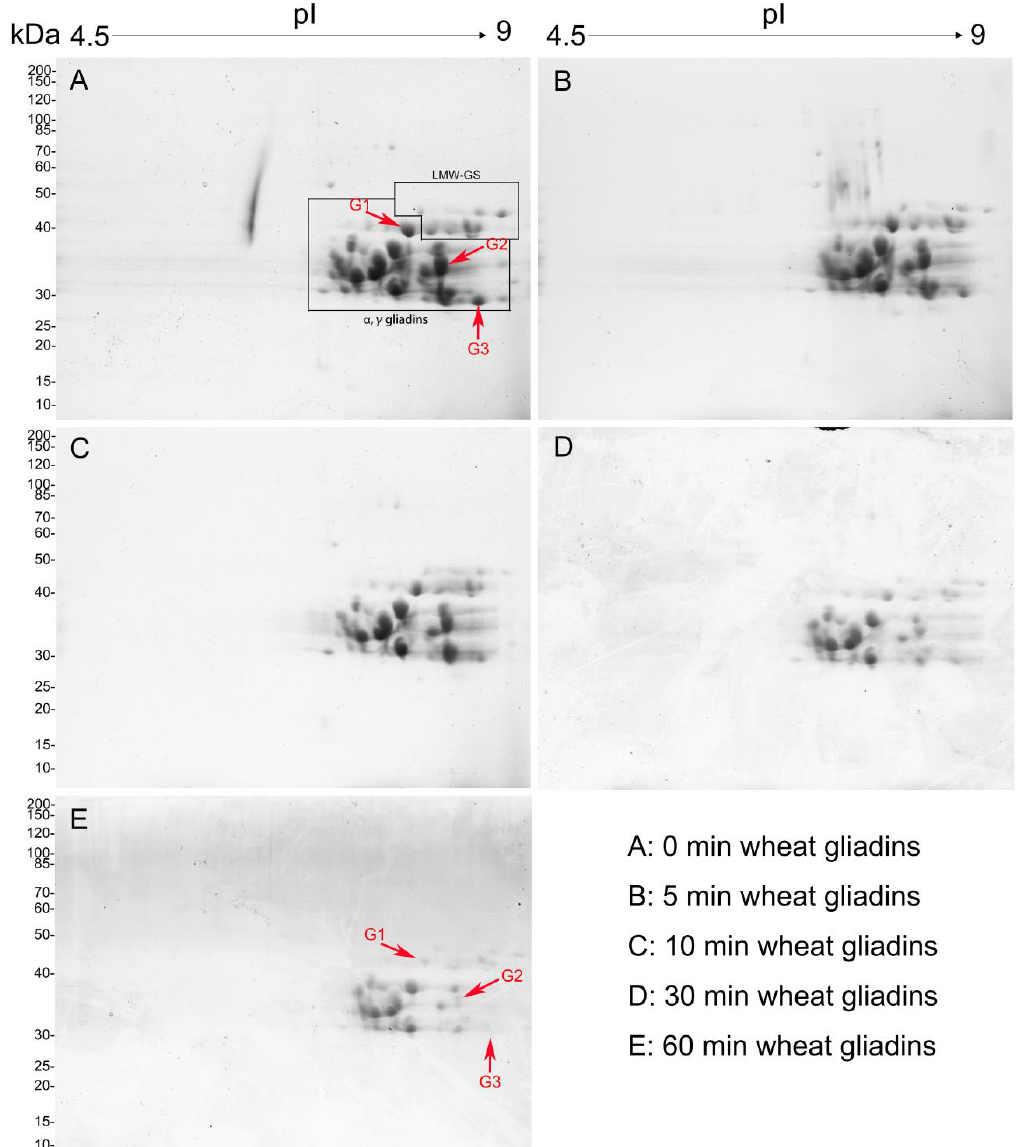
Figure 8. 2-DE detection of protein species in native and CJAP plasma-modified wheat gliadins. The major groups of wheat gliadins are indicated. The molecular weight is indicated on the vertical axis, and isoelectric point is shown on the horizontal axis. The A-E are the wheat gliadin samples treated with CJAP plasma for 0, 5, 10, 30 and 60 min, respectively.